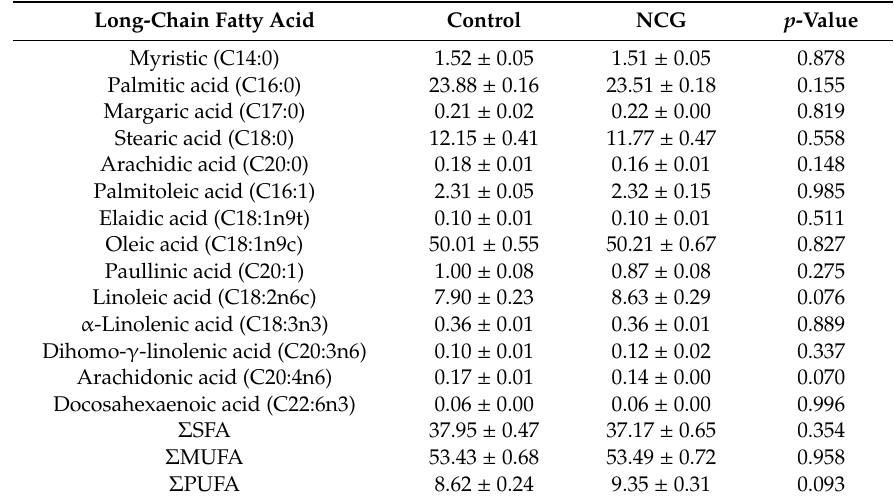
Table 6. E ff ect of dietary N -carbamylglutamate on long-chain fatty acid composition (% of total fatty acids) in the abdominal subcutaneous adipose of Ningxiang pigs.